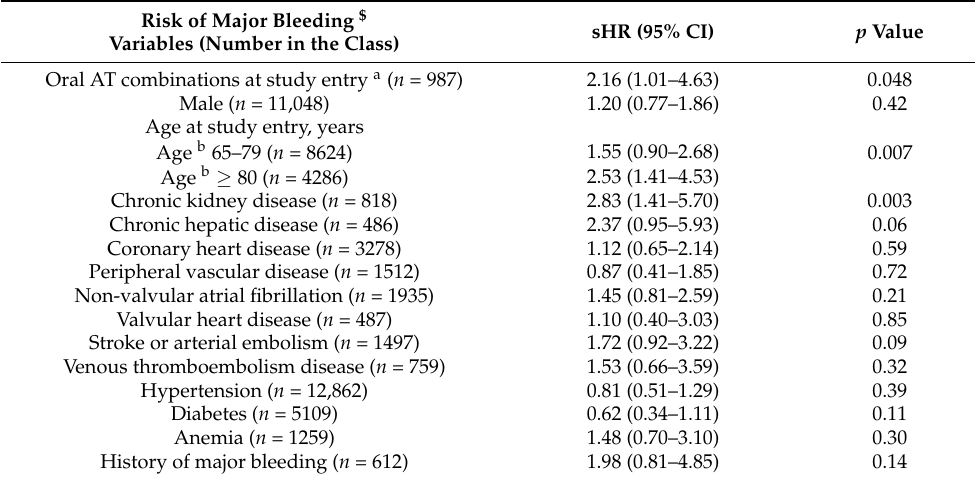
Table 3. Risk of major bleeding in individuals starting the study with oral antithrombotic (AT) combinations ( n = 987) versus individuals starting the study with oral AT monotherapy ( n = 21,233) as a reference (estimated by the fitted Fine and Gray model with death as competitive event).